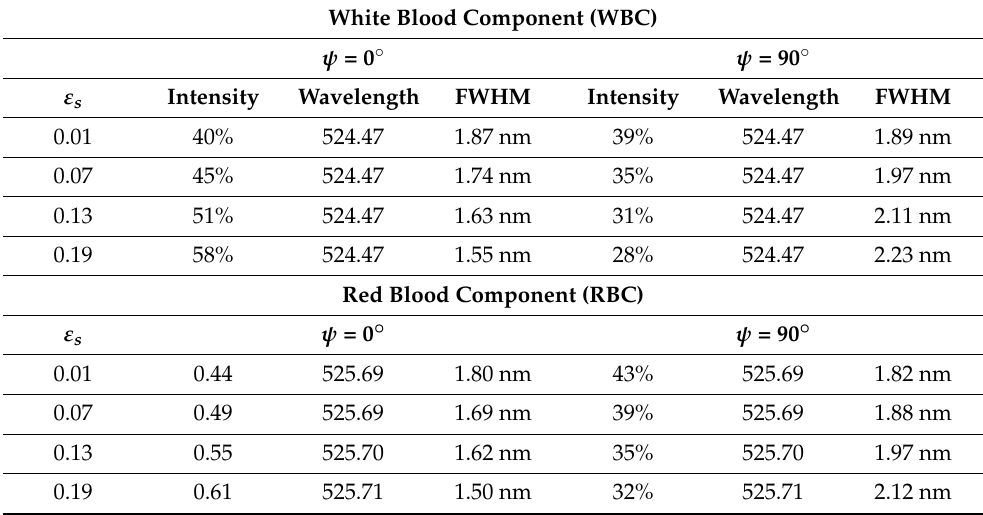
Figure 8. Values of figure of merit (FOM) ( a , c ) and detection accuracy (DA) ( b , d ) versus ε s and light incident angle for two samples of WBC (solid lines) and RBC (dashed lines), at ψ = 0 ◦ and 90 ◦ . The values θ 0 and ε s are considered as 0 ◦ and 0.2 in panels ( a , b ) and ( c , d ), respectively. Table 2. Values of the intensity, central wavelength, and FWHM for WBC and RBC resonant modes at different amounts of the ψ and ε s